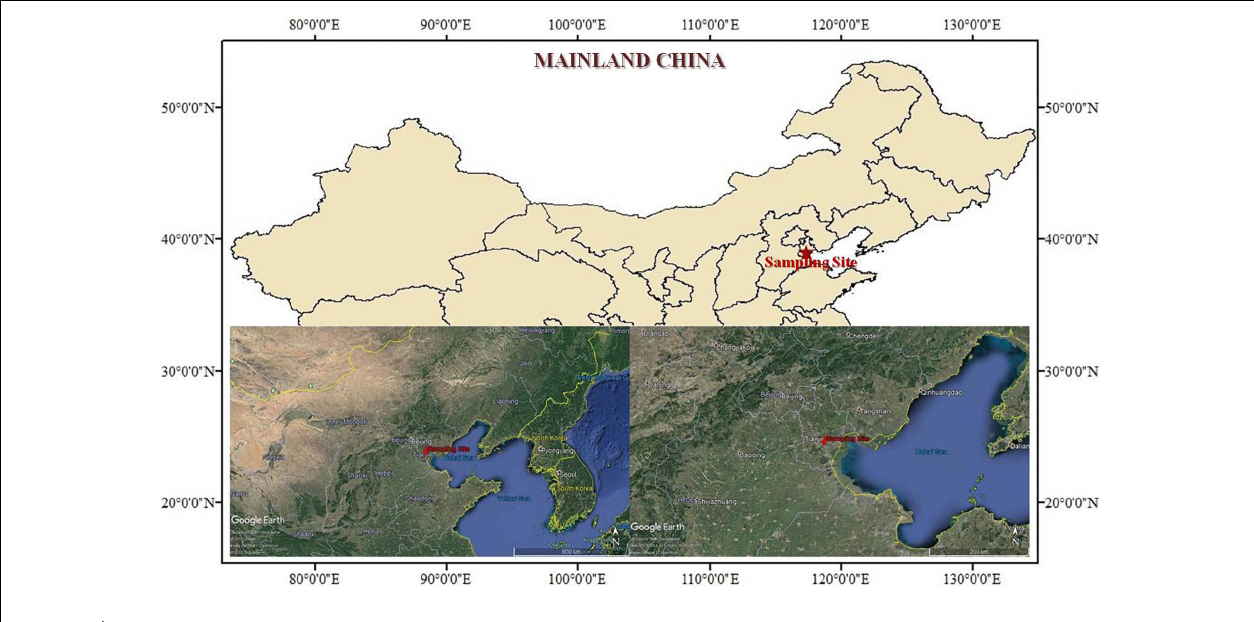
FIGURE 1 | Sampling site